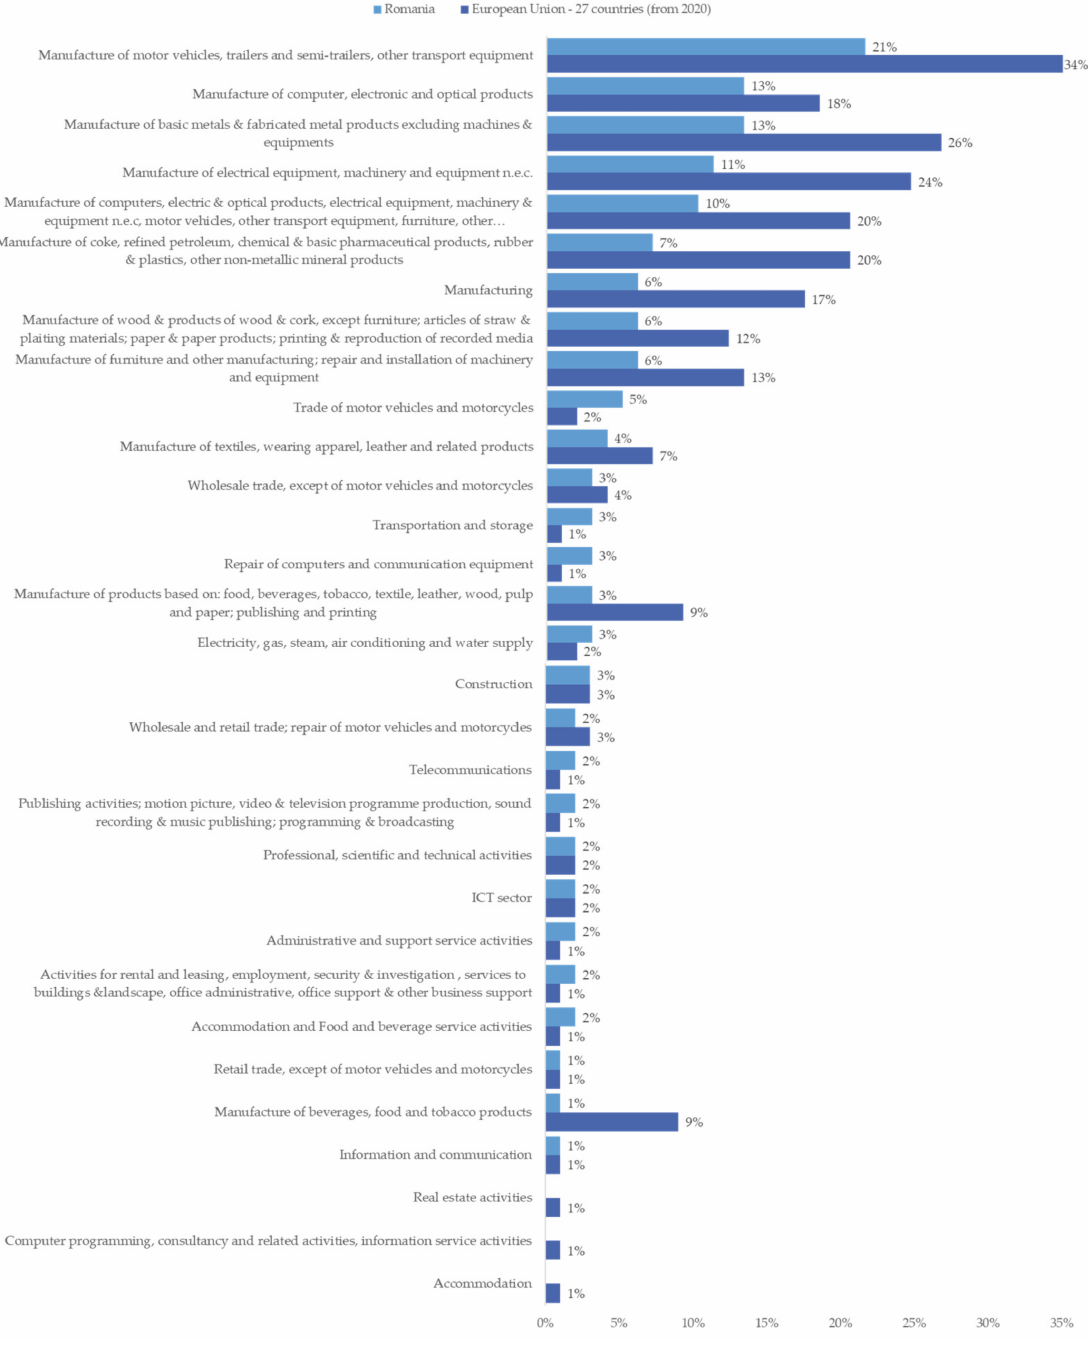
Figure 6. Share of enterprises using industrial robots out of the total enterprises that used industrial robots in, 2020—Romania compared to EU27 averages. Source: Author’s Contribution. Data re- trieved from Eurostat. Robotics and 3D Printing Data, https://ec.europa.eu/eurostat/databrowser/ bookmark/f29db2df-2e19-4bfd-8bb4-af630dc3e907?lang=en, accessed on 15 March